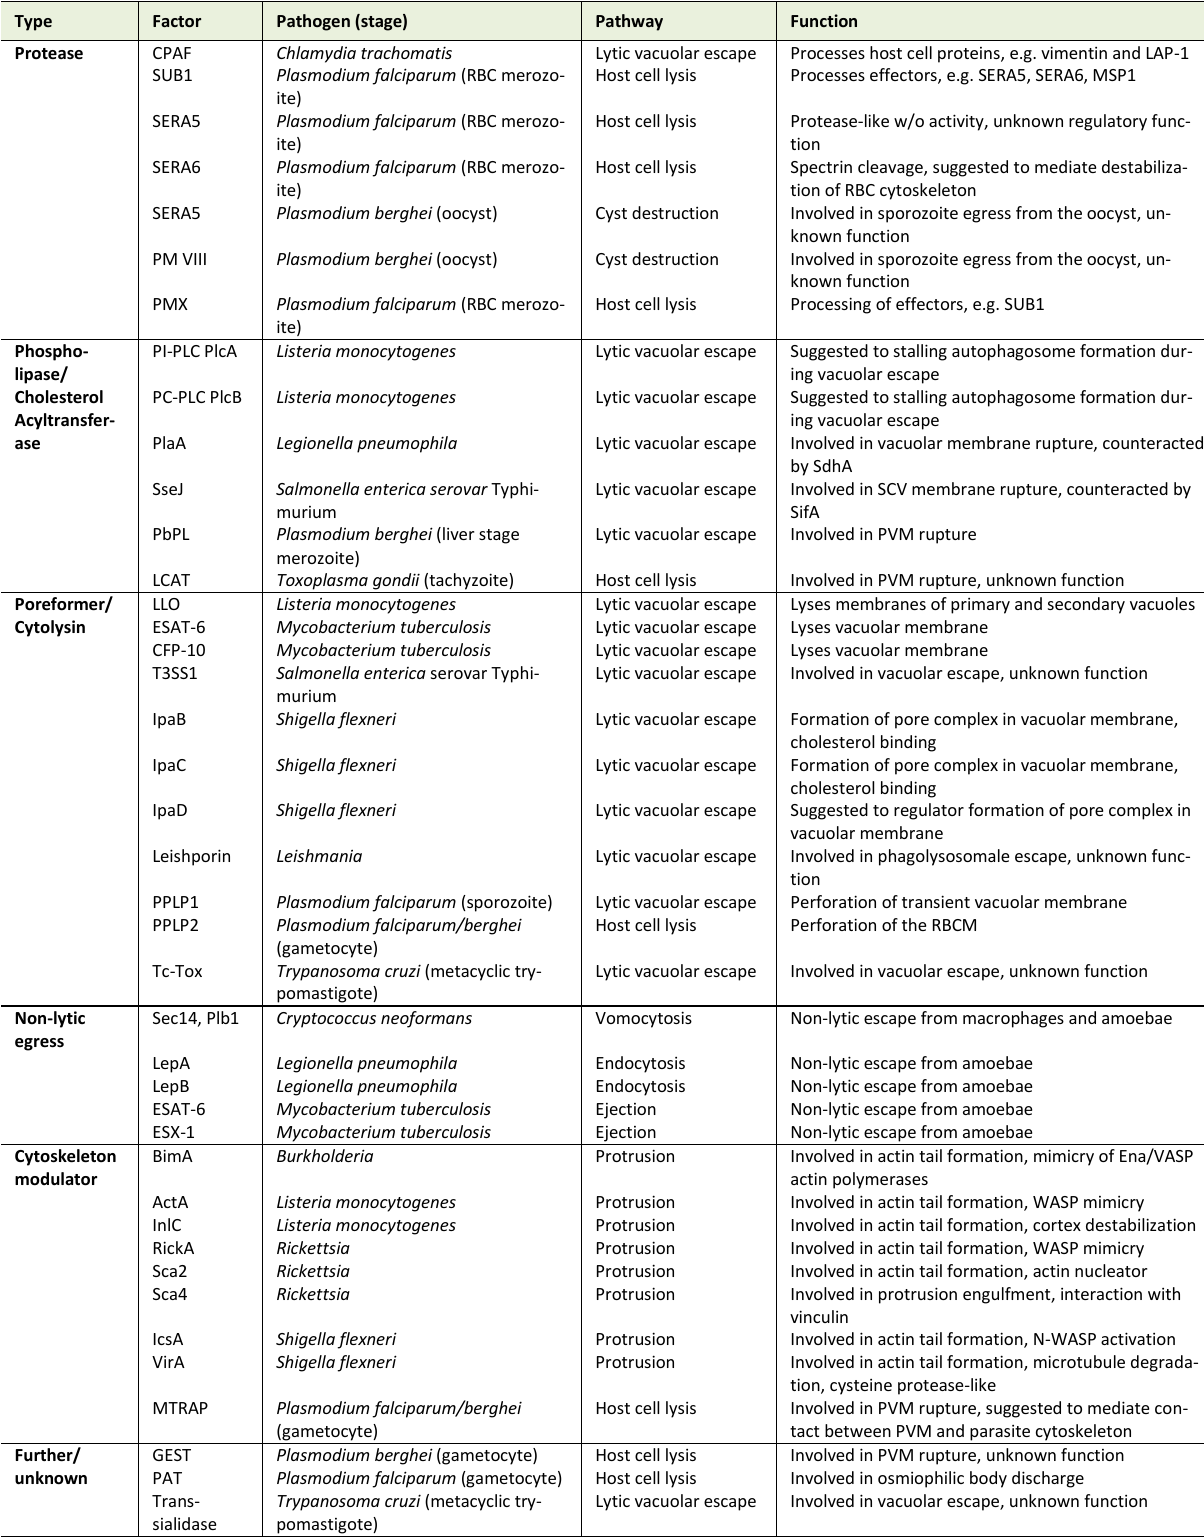
Table 1. Microbial key factors of host cell exit.